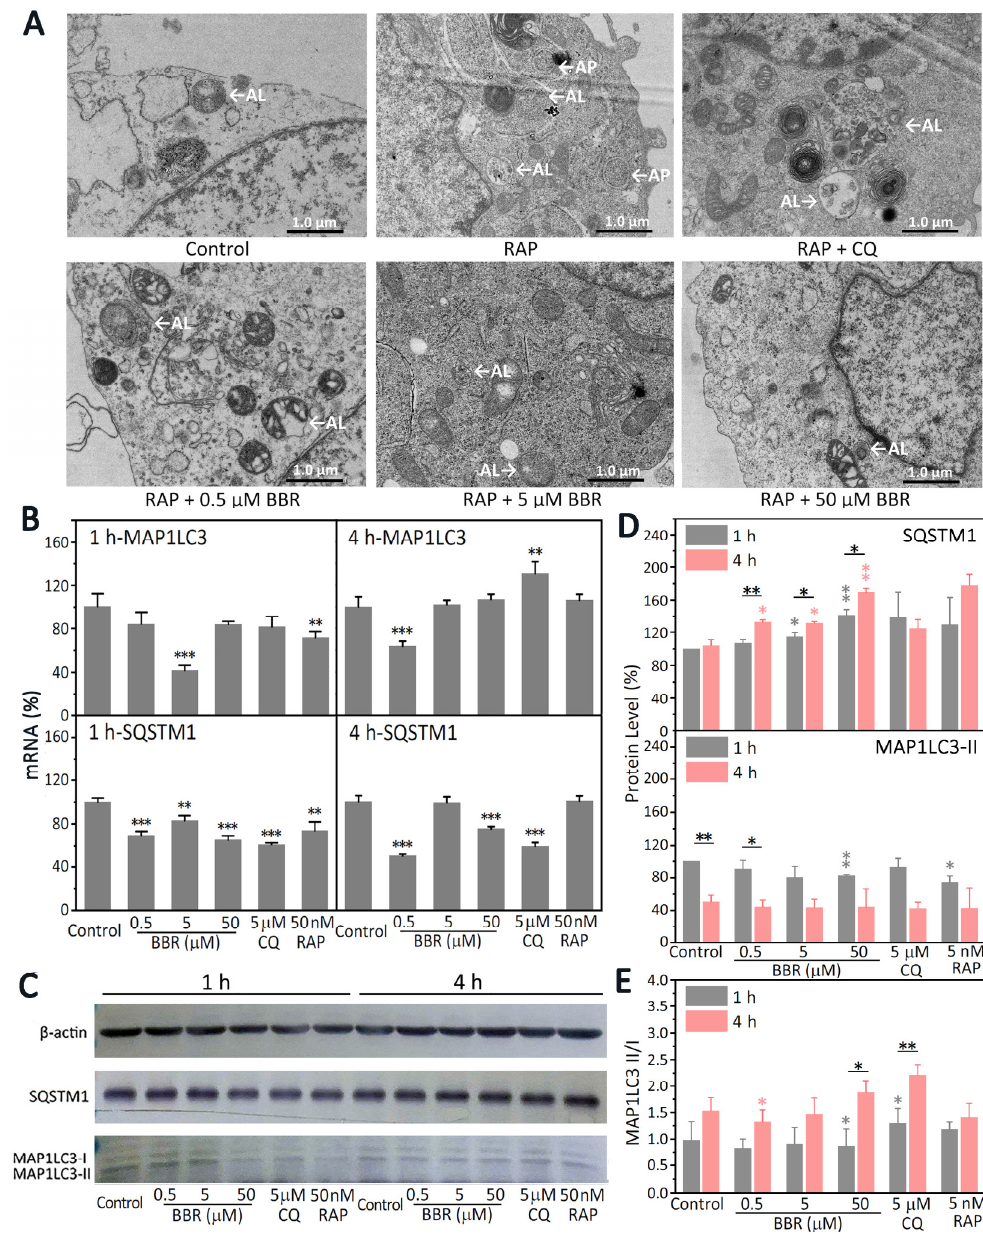
Figure 4. BBR inhibited the autophagy of MDA-MB-231 cells. MDA-MB-231 cells were treated with 0.1% DMSO, 50 μM BBR, 5 μM CQ, or 50 nM RAP for one hour. ( A ) BBR’s effect on the characteristic autophagic structures in MDA-MB-231 cells. Scale bar: 1.0 μM. ( B ) The mRNA expression of SQSTM1 and MAP1LC3 was determined by RT-PCR. GAPDH was set as the reference. The data are presented as mean ± SEM; n = 5. p < 0.01 (**), p < 0.001 (***). ( C ) The protein level of SQSTM1 and MAP1LC3 in MDA-MB-231 cells was detected by Western blot. β -actin was used as the loading control. ( D ) The protein expression levels of SQSTM1 and MAP1LC3-II were calculated relative to the expression of β -actin, n = 3. p < 0.05 (*), p < 0.01 (**). ( E ) The average ratio of MAP1LC3-II/MAP1LC3-I is shown, n = 3. p < 0.05 (*), p < 0.01